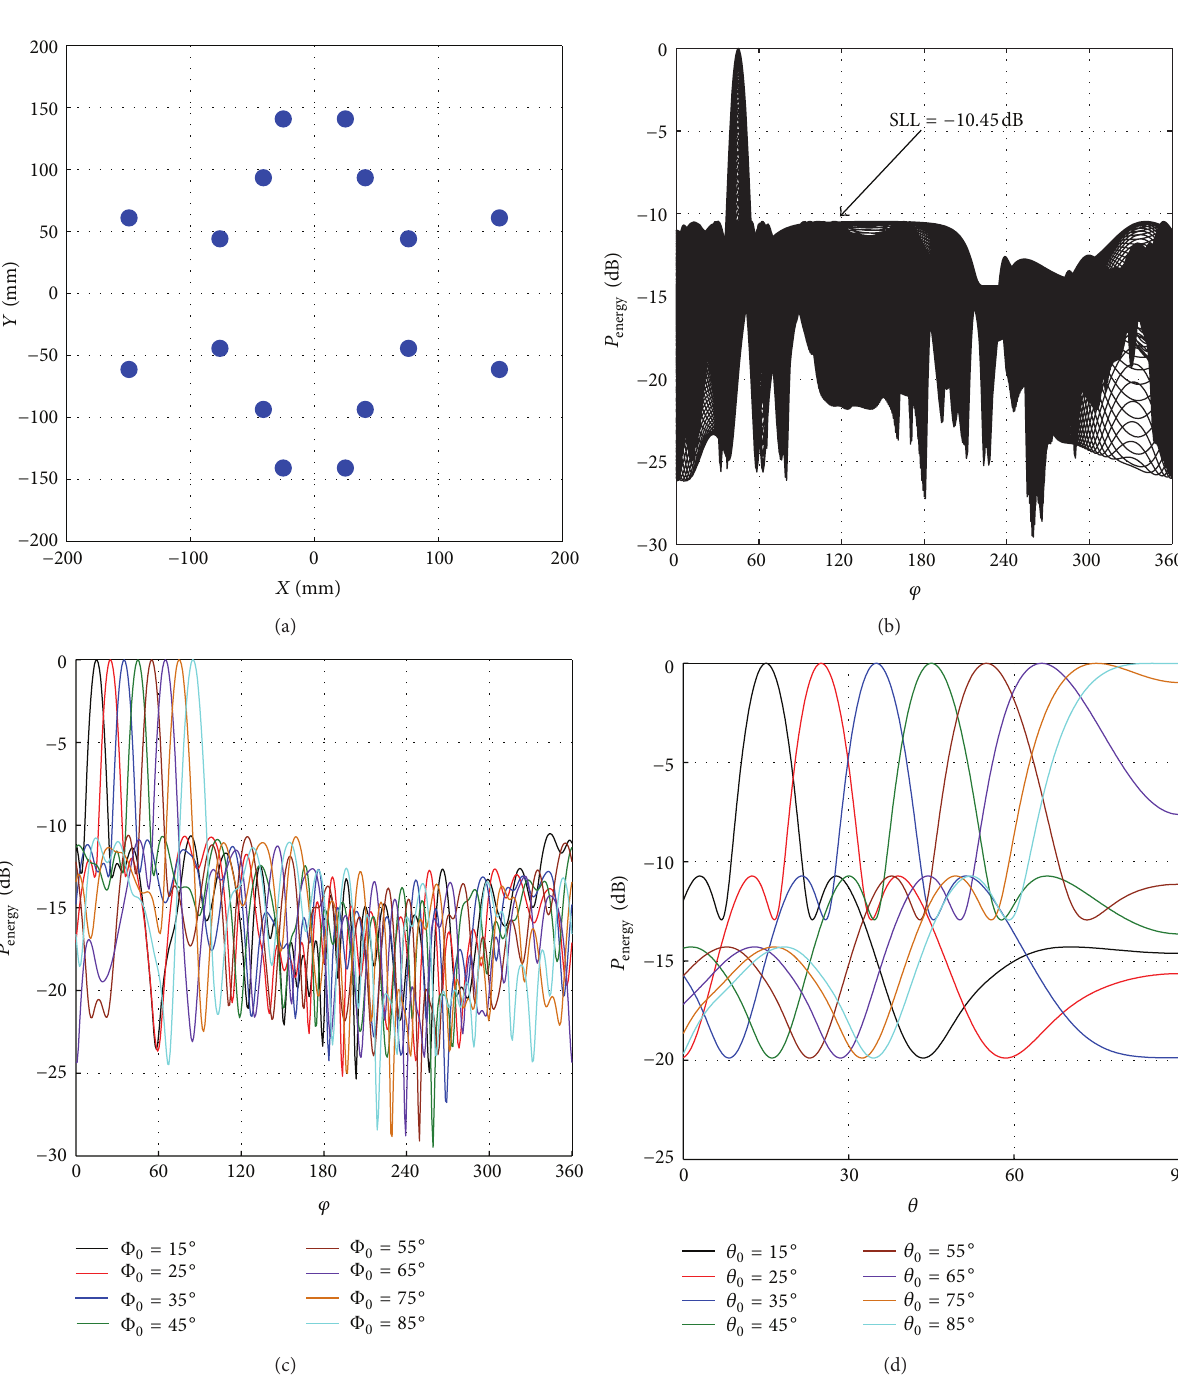
Figure 3: Result of RA: (a) antenna and delay distributions, (b) SEP in 𝜃 0 = 𝜑 0 = 45 ∘ , (c) azimuth cuts with 𝜃 0 = 45 ∘ , and (d) elevation cuts with 𝜑 0 = 45 ∘